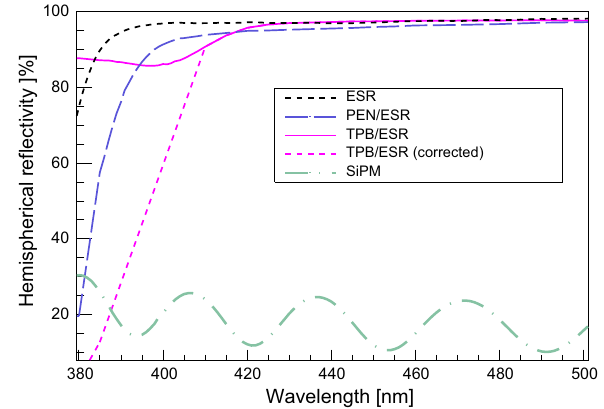
Table 1 Systematic uncertainties on key inputs to the Monte Carlo simulation and their relative effect on the final LY ratio of PEN and TPB configurations. See text for more